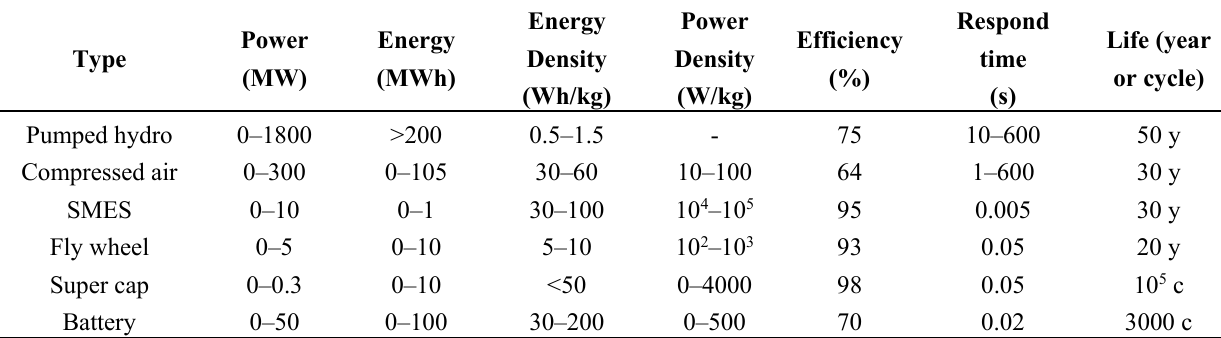
Table 1. Characteristics of typical energy storage